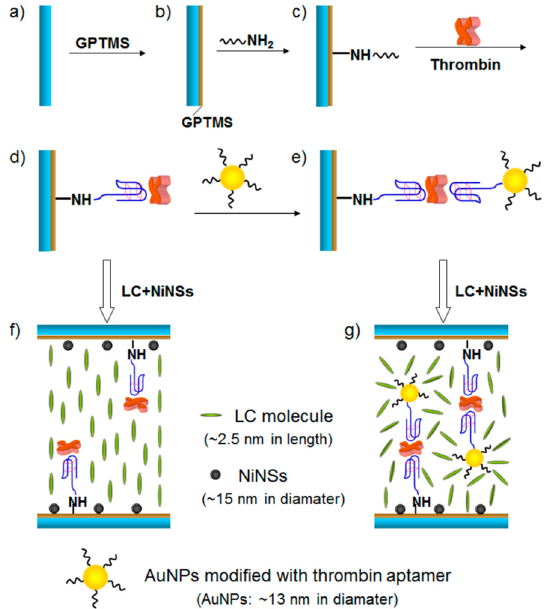
Figure 6. Schematic illustration of the detection method and preparation steps for the NiNS-based thrombin LC sensor: ( a ) cleaned glass slide; ( b ) self-assembled GPTMS film; ( c ) immobilization of the antithrombin aptamer; ( d ) thrombin addition and binding with the aptamer; ( e ) binding with Apt-AuNPs; ( f ) orientation of the LC mixture (5CB doped with 0.01 wt % NiNS) in the LC cells assembled with thrombin; ( g ) orientation of the LC mixture in the LC cells assembled with Apt-AuNPs through a sandwich format [26].